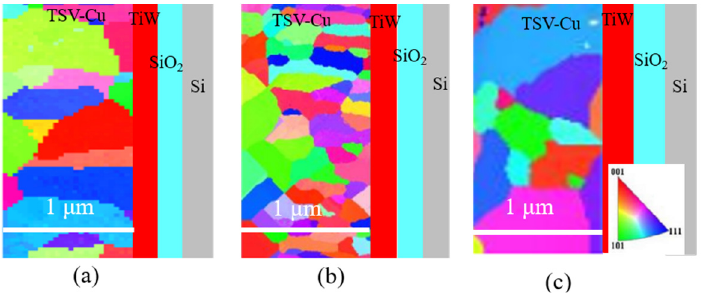
Figure 7. EBSD images of TSV-Cu under the different thermal loading conditions: ( a ) as fabricated; ( b ) thermal cycling; ( c ) annealing. ( b ) thermal cycling; ( c ) annealing.